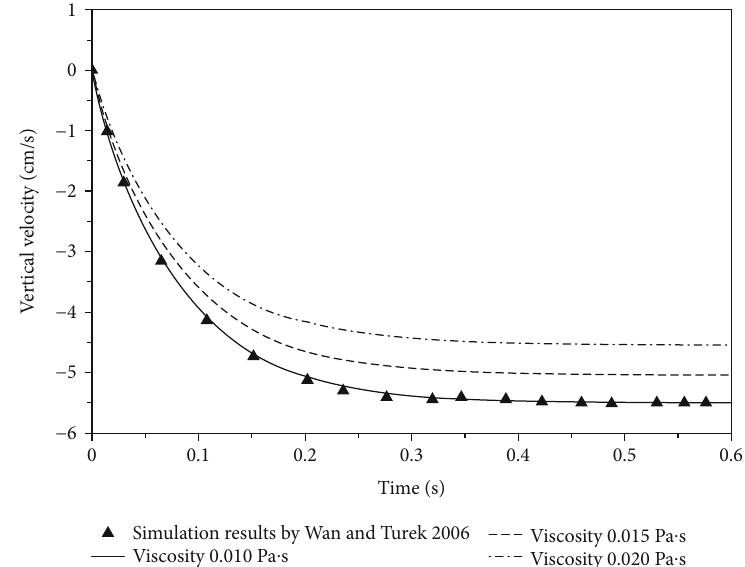
Figure 4: Comparison of vertical velocity of a solid particle in fl at pipe with varying viscosity.